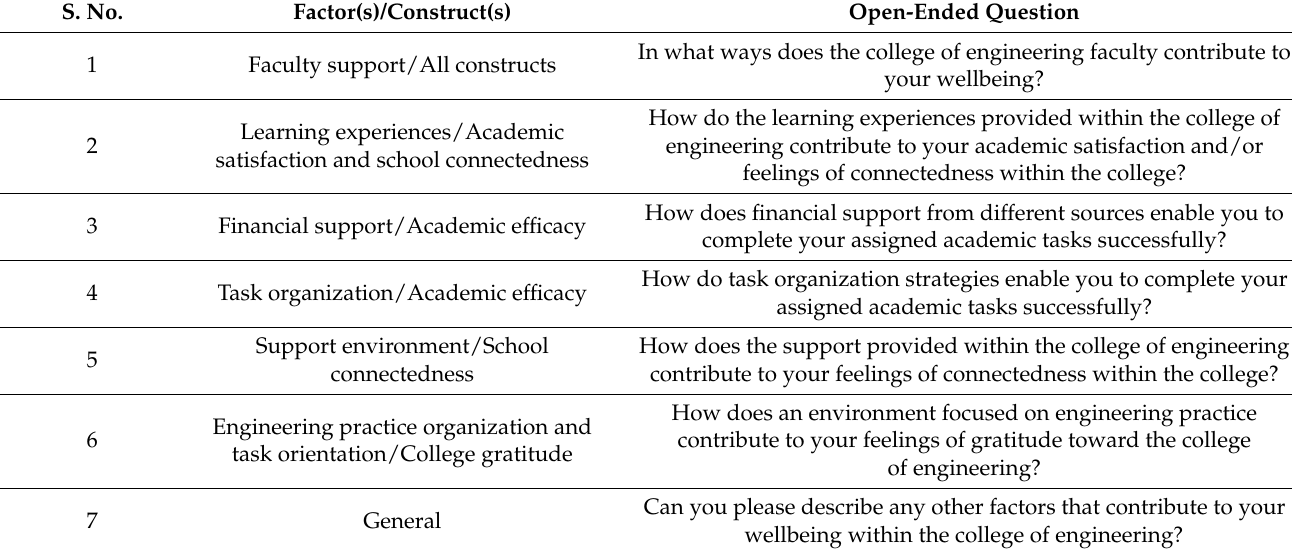
Table 3. Open-ended survey questions developed from the study